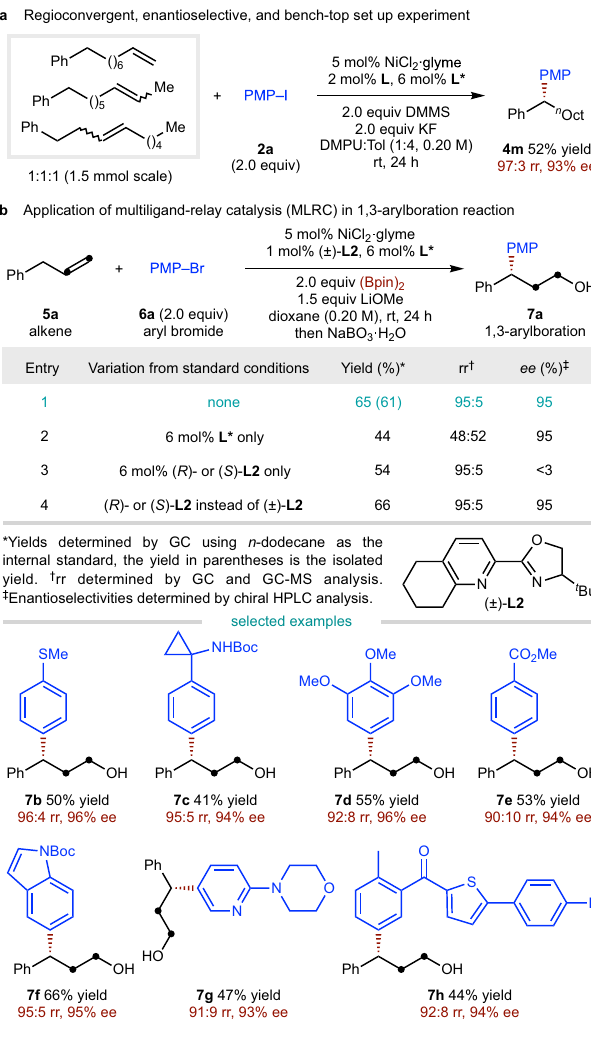
Fig. 5 Regioconvergent experiment and further application. a Regioconvergent, enantioselective, and bench-top set up experiment. b Application of multiligand-relay catalysis in 1,3-arylboration reaction.